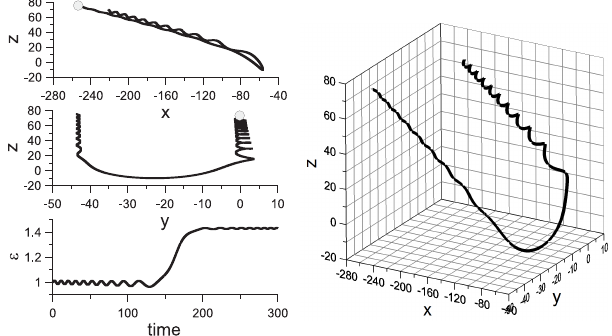
Fig. 4. Trajectory of Speiser particle in the region of quasi-adiabatic motion ˆ ‘ x > | x | > ‘ x . Also energy evolution is